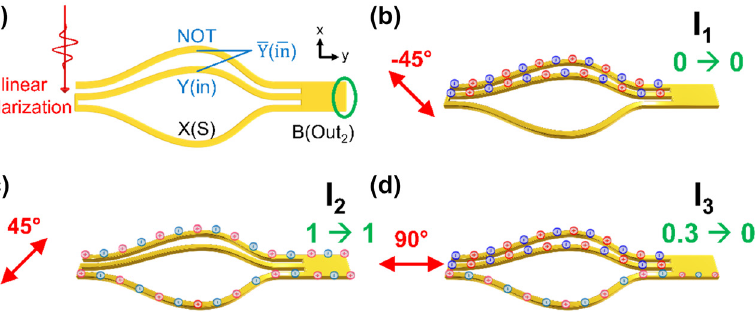
Figure 2: Parallel INHIBIT AND circuit. (a) Schematics of the pure parallel transmission-line based INHIBIT AND design. A linearly polarized laser beam excites SPPs at the input. A single-stub termination serves as the output B (Out ) intensity detector. An additional metallic 2 nanowire (NOT) having an identical length to the bottom nanowire (X(S)) is added to the TWTL. The length of the nanowire labelled Y (in) is 𝜆 /2 shorter (introducing a 𝜋 phase difference) as compared to the two other nanowires. (b) When the laser polarization is − 45 ◦ , SPPs are SPP excited on NOT and Y (in) nanowires. The initially excited symmetric mode is converted to antisymmetric mode at the mode detector, leading of 0. (c) For laser polarization of 45 ◦ , SPPs on the NOT and X(S) wire are excited. Symmetric mode is maintained to the output intensity I 1 upon reaching the mode detector, leading to a strong scattered intensity I . (d) For 90 ◦ polarization, SPPs are guide on all three nanowires. 2 ), leading to a weak I Only a portion of the SPPs guided by wire X(S) is scattered at B (Out 2 3